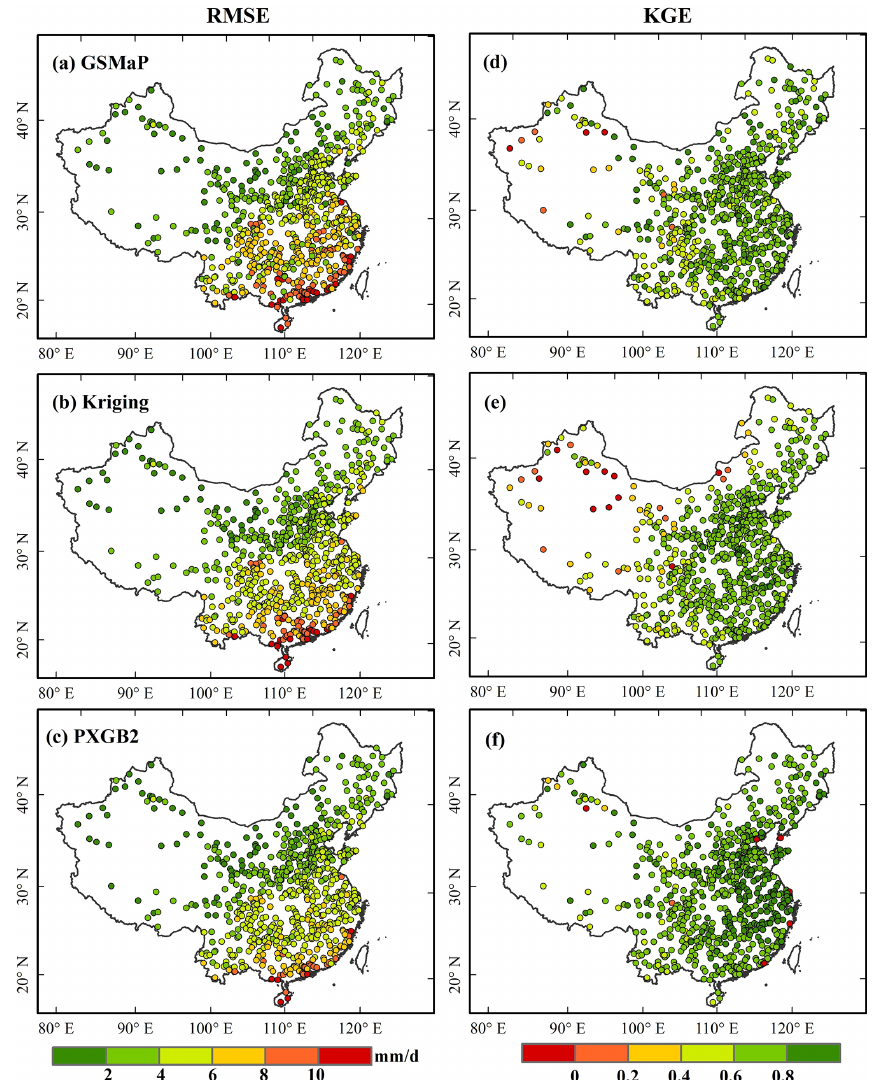
Figure 8. Spatial distribution of RMSE (a–c) and KGE (d–f) for GSMaP (a, d) , Kriging (b, e) , and PXGB2 (c, f) in the whole period from 2000 to 2017 using independent rain gauges over mainland